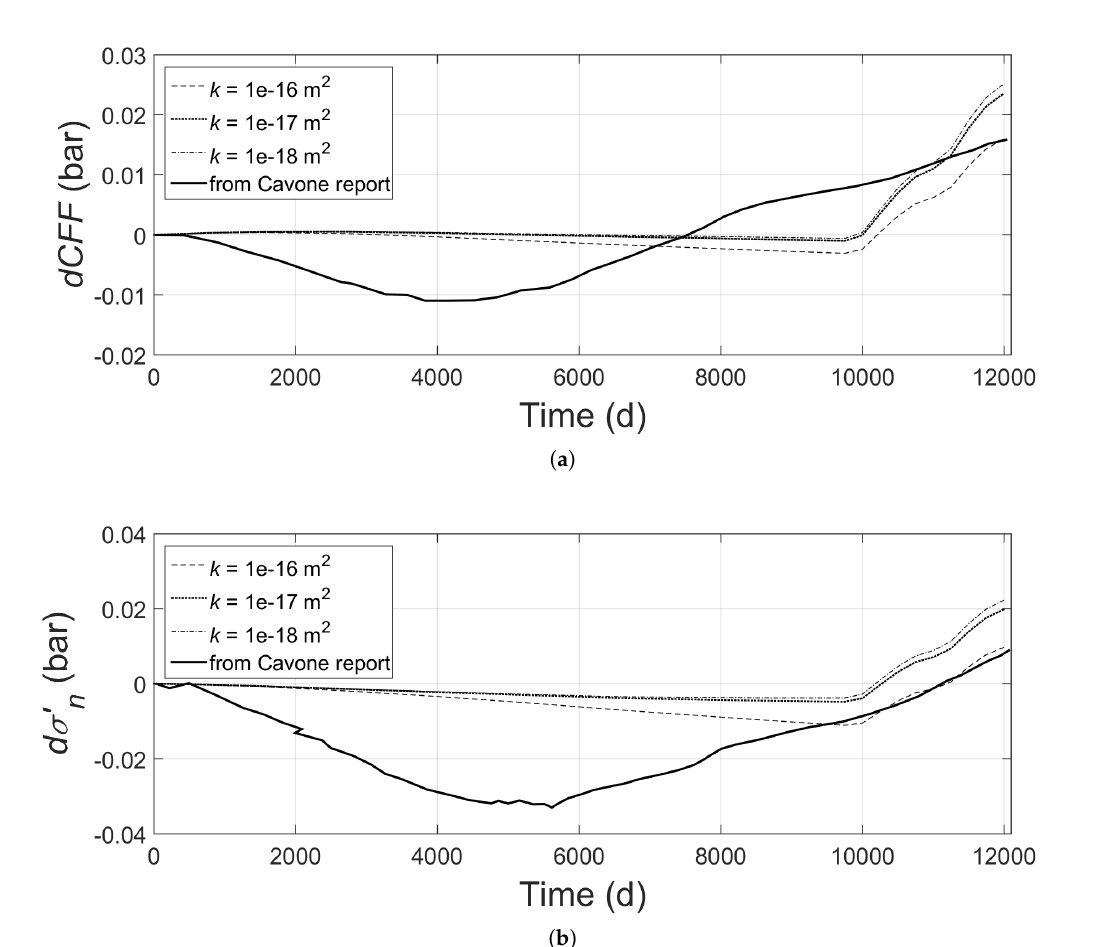
Figure 22. Blind Mirandola fault and Cavone oilfield modeling: Coulomb stress change dCFF (bar) ( a ) and effective normal stress change d σ (cid:48) n (bar) ( b ) evaluated at the hypocentre for variable permeability of the lower caprock layer k lower (1 mD = 10 − 15 m 2